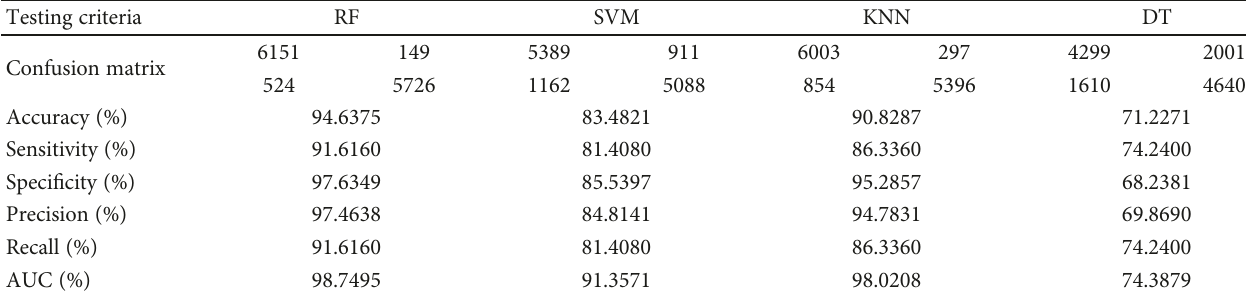
Table 10: Performance measures of the classi fi ers for IDU dataset.